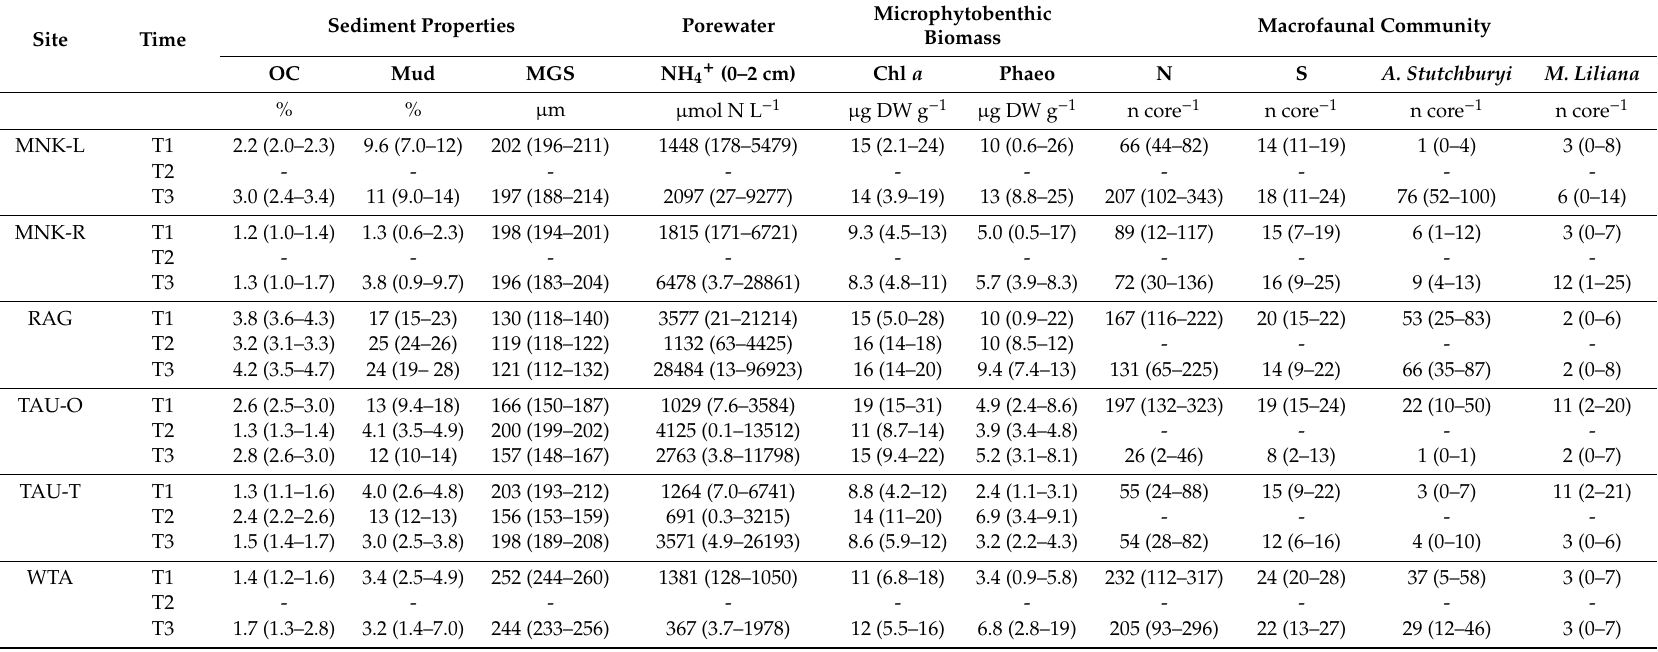
Table 2. Site characteristics during November 2017 (T1), June 2018 (T2) and November 2018 (T3). Data presented are an average across the three nutrient enrichment treatments (n = 9), with the range in